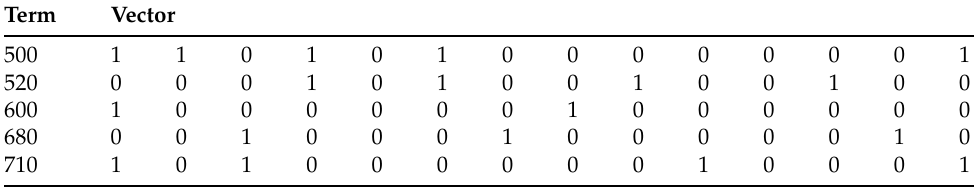
Table 1. Inverted index